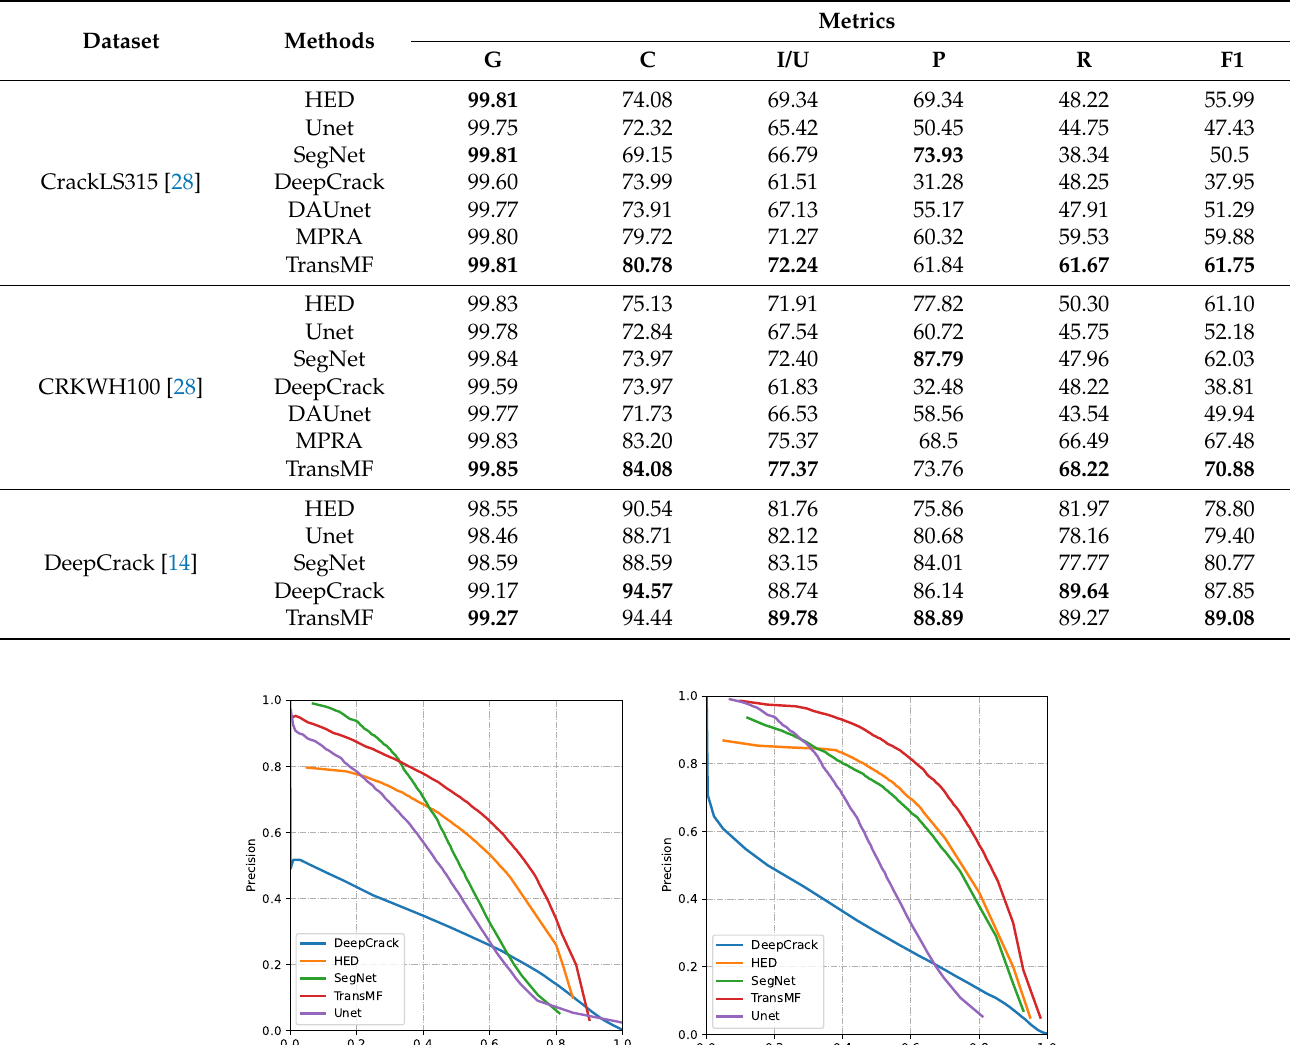
Table 2. The results of comparison among baselines of TransMF on three datasets. The bold means that the best result for each baseline method.